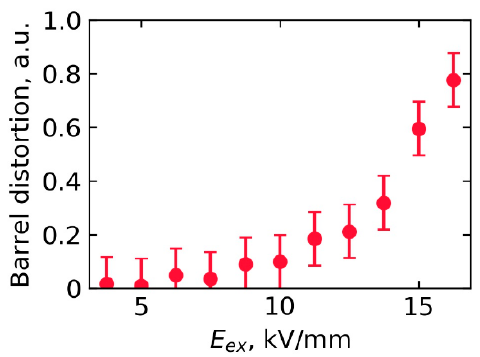
Figure 10. Field dependence of the slow Y- wall velocity fitted by Equation ( 1 ) (red line) and Equation ( 2 ) (green line).